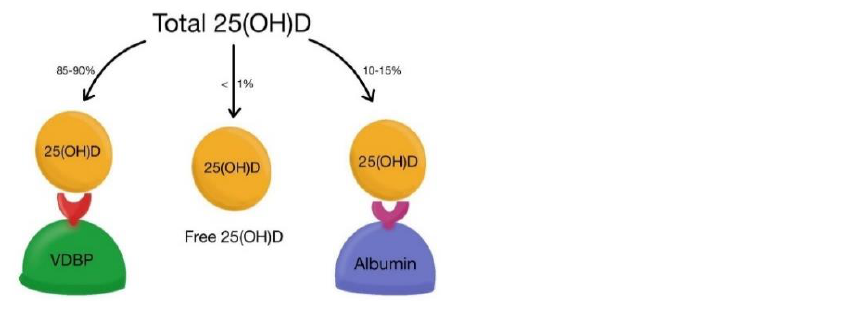
Figure 3. Total 25(OH)D in serum is bound to vitamin D binding protein (VDBP), 85–90%; albumin, 10–15%; and <1% circulates free. Bioavailable vitamin D refers to vitamin D3 and D2, which are not bound to VDBP (Adapted from Fernando M, [31]).